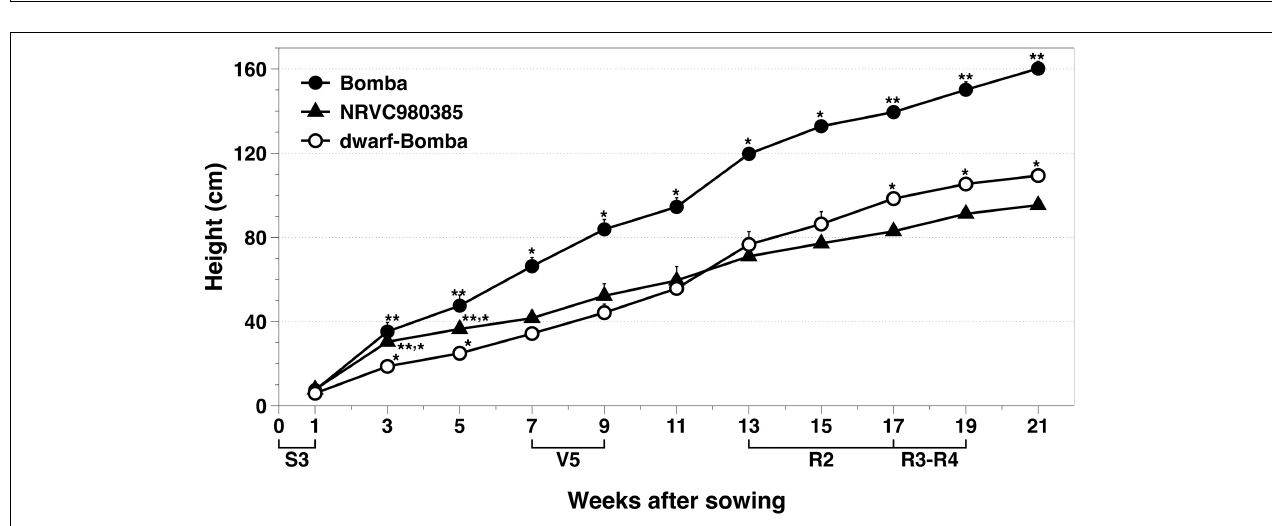
FIGURE 3 | Monitoring of the rice heights of the three Mediterranean japonica rice varieties used. Values correspond to Asterisks indicate significant differences between rice varieties in each measurement week.